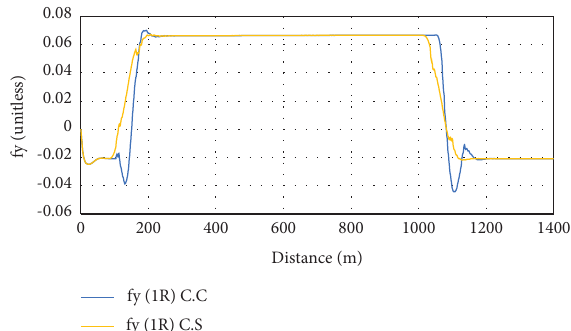
Figure 14: Comparison of side friction factors along the path between simple and spiral horizontal curves for a